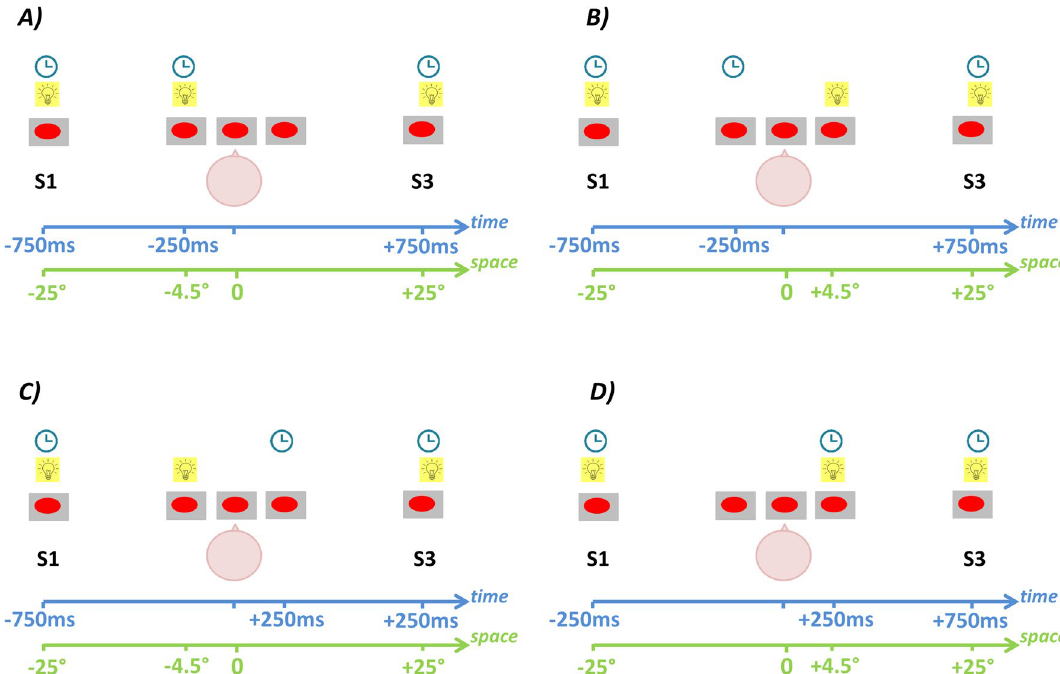
Figure 2. Experimental protocol for visual time- and space-bisection tasks. For each trial, individuals saw a series of three flashes (S1, S2, S3) that lasted 1.5 s with S1 and S3 at a fixed position of ± 25° with respect to the individual midline. S2 could occur randomly and independently at ± 250 ms (top and bottom panels) and from ± 4.5° (left and right panels) with regard to the physical spatial and temporal midpoints (0° and 0 ms). Interaction of spatial distance and temporal delay of S2 gave rise to four different conditions: ( A ) S2 from − 4.50° at − 250 ms; ( B ) S2 from + 4.50° at − 250 ms; ( C ) S2 from − 4.50° at + 250 ms; ( D ) S2 from + 4.50° at + 250 ms. S2 delivered from − 4.5°, and + 4.5° corresponds to S2 provided from the left or right side of the subject, respectively. Participants were instructed to judge whether the position of S2 in time or space (two separate blocks) was farther from S1 or S3 (bisection